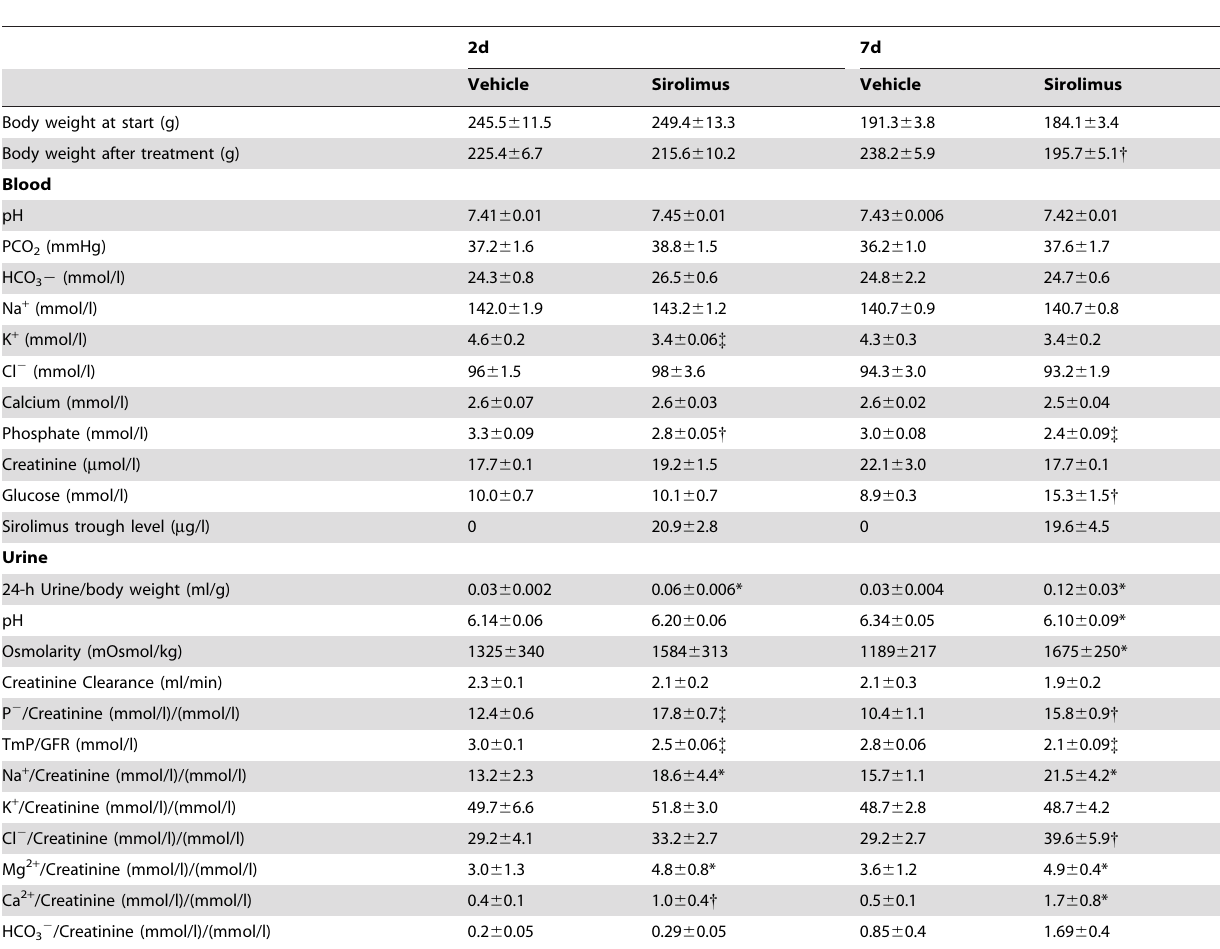
Table 1. Blood and urine parameters from vehicle and sirolimus-treated rats after two and seven days of